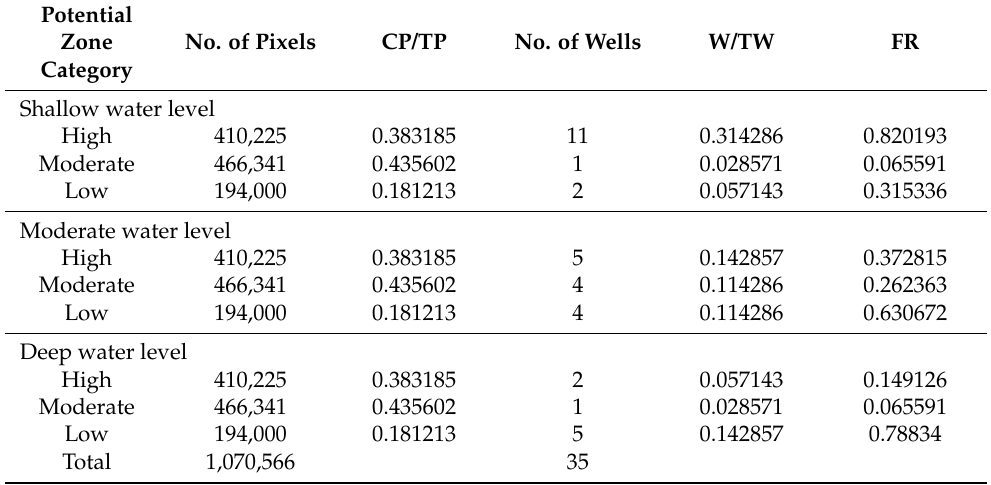
Table 6. Frequency ratio between water level and subsurface parameter-based groundwater potential zones.